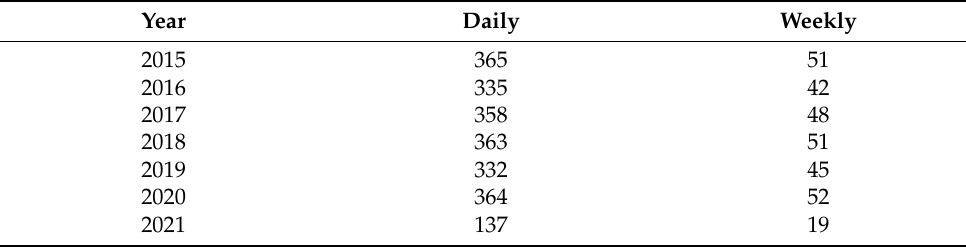
Table 1. Number of bulletins in the LGS